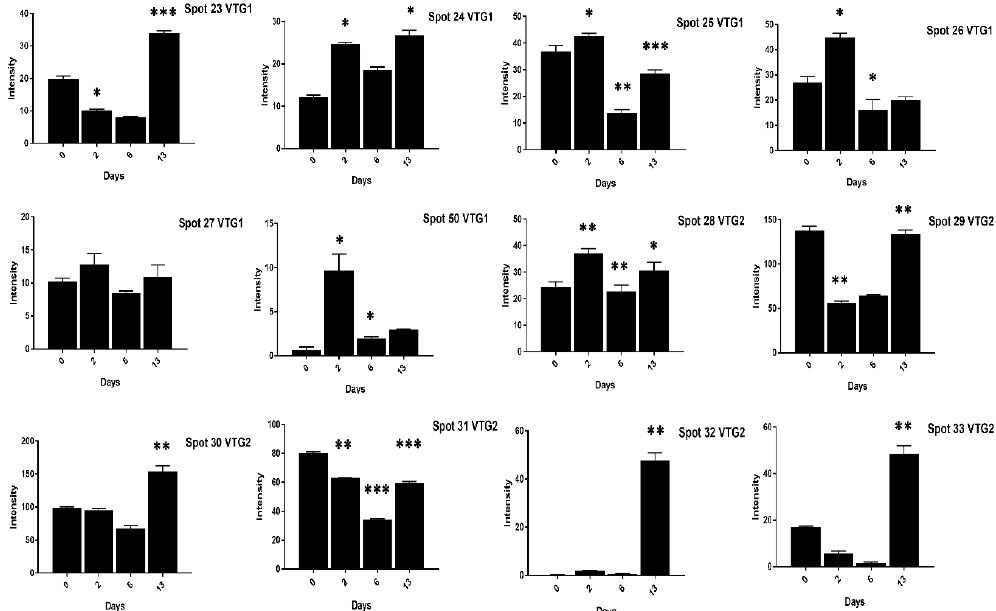
Figure 3. The changes in the intensity of fertilized egg yolk proteins corresponding to Figure 1 has been shown. The VTG-1 and VTG-2 protein spots expression at 0, 2, 6, and 13 days of incubation are indicated in high cholesterol eggs. The column profiles of VTG-1 (23–27, 50) and VTG-2 (28–33) are shown as bar charts with significant differences. The significant differences were determined from the comparison with the control and the asterisks denote statistically significant differences. The data represent the mean values (±SD) from three replicates. * p < 0.05, ** p < 0.005, *** p < 0.0001. At 13 days of incubation, the VTG-2 protein 12 spots (28–35, 41, 45, 46, 65) in high cholesterol (Figures 3 and 4) and 6 spots (29, 32–35, 41) in low cholesterol eggs (Figures 5 and 6) were highly significant. The VTG-1 protein also showed increased expression after 13 days of incubation in both egg types (Figures 3 and 5). The VTG-3 protein spots (48, 49, 74) showed a consistent decrease in expression with the increase of incubation days in high cholesterol eggs such as at two days of incubation the spots (48, 49, 74) were highly significant while decrease at six days and 13 days of embryogenesis (Figure 4).